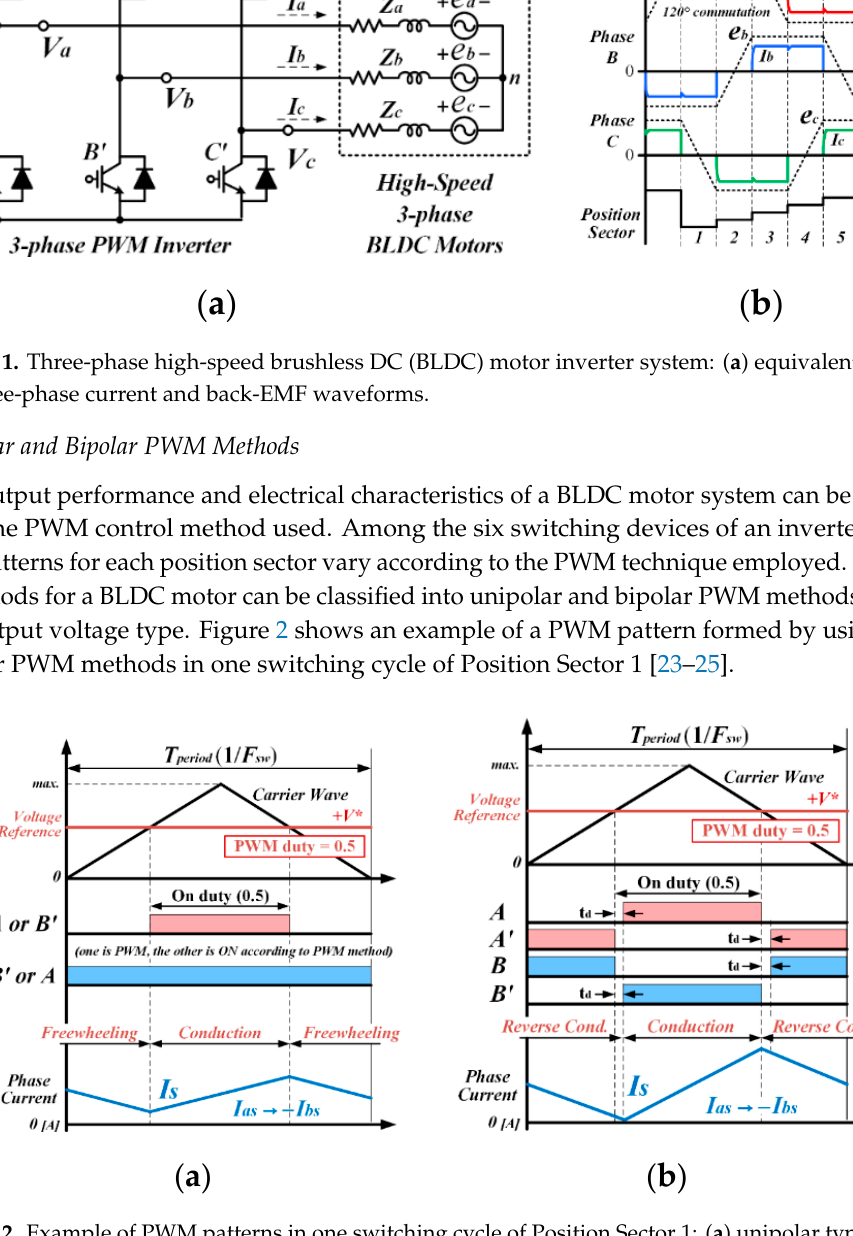
Figure 1. Three-phase high-speed brushless DC (BLDC) motor inverter system: ( a ) equivalent circuit; ( b ) three-phase current and back-EMF waveforms.